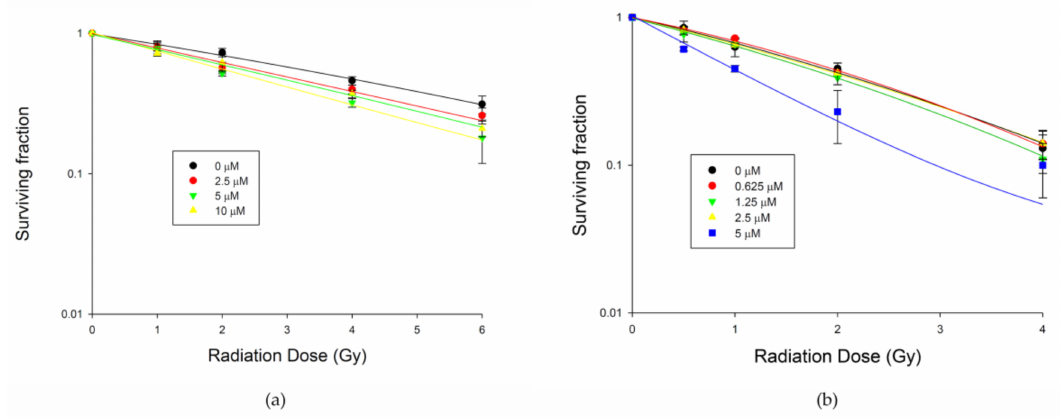
Figure 5. Moscatilin enhanced the radiosensitivity of human esophageal cancer cells. ( a ) BE3 cells. ( b ) CE81T/VGH cells. Clonogenic assay was used to estimate the survival of esophageal cancer cells. Significant difference between control cells and cells treated with moscatilin 10 µ M in BE3 cells or 5 µ M in CE81T/VGH cells from colony formation data using Student’s t -test analysis are indicated as * p <